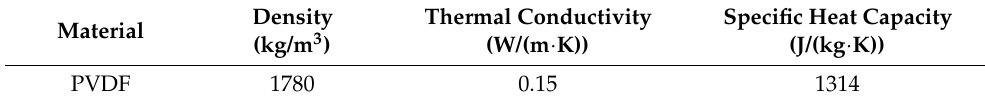
Figure 2. ( a ) Simulation models of non-structured, grooved, square-pitted and sinusoidal PVDF films. ( b – g ) Simulation results: ( b ) temperature distribution at t = 5 s for all models; ( c ) temperature distribution along wire probe lines at different times for all models; ( d ) ∫ dT / dt over the film surface for all models; ( e ) influences of θ and W on (∫ dT / dt) max of the grooved and square-pitted films; ( f ) influences of Th and W on (∫ dT / dt) max of the sinusoidal films; ( g ) influences of Th on (∫ dT / dt) max of the structured and non-structured films. Table 1. Physical properties of PVDF.